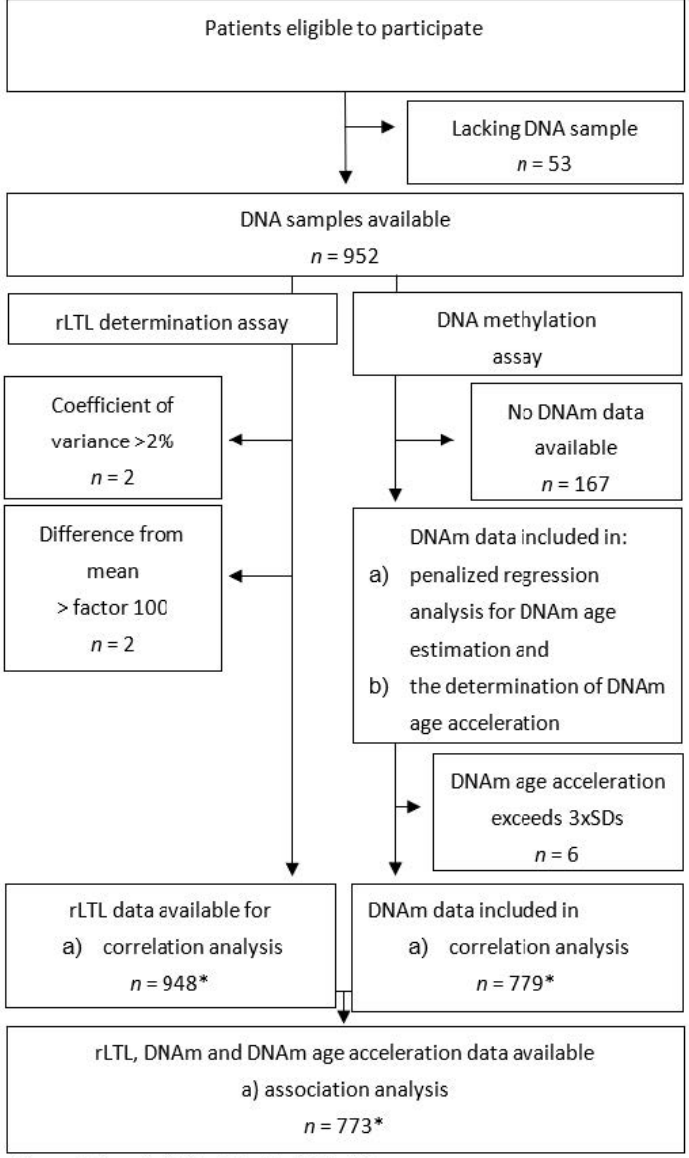
Figure A1. Composition and sample size ( n ) of the LipidCardio study (sub)populations .